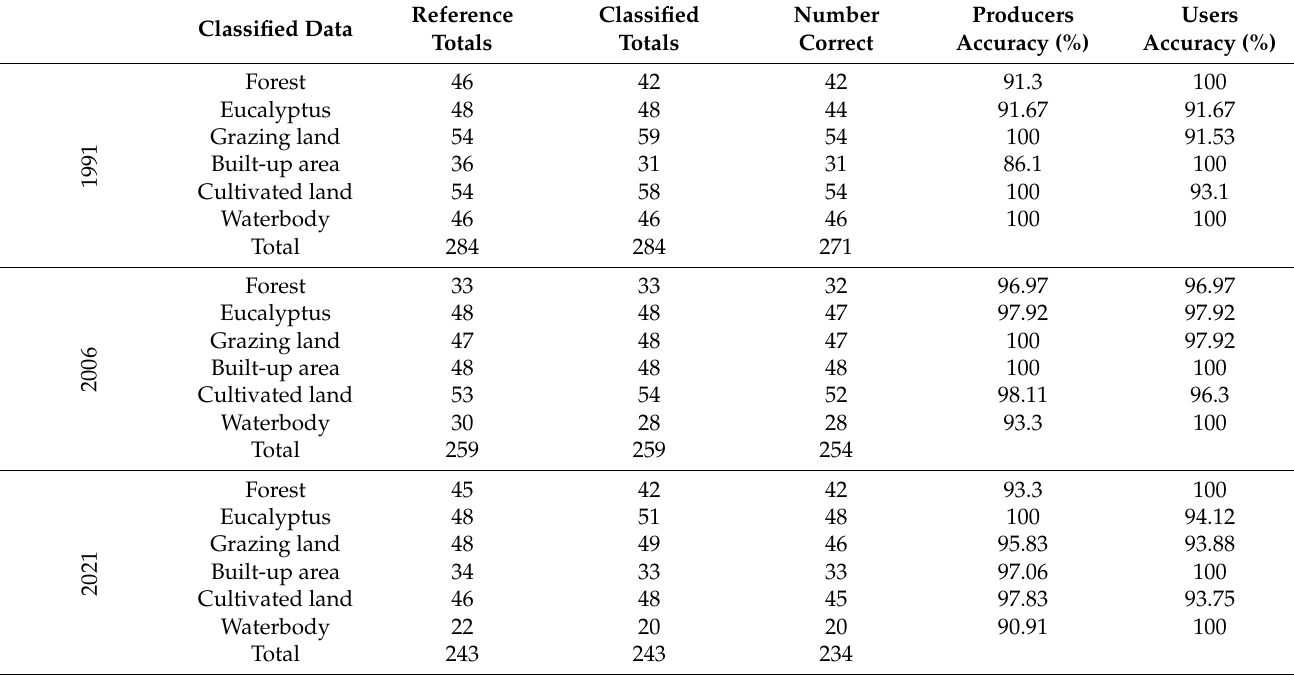
Table 3. Accuracy assessment for 1991, 2006, and 2021 classified image.